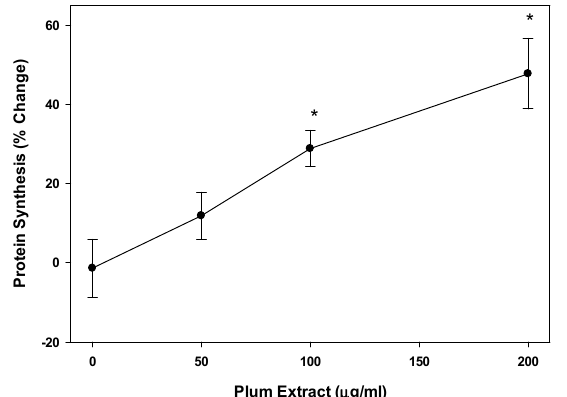
Figure 3. The effect of plum extract on myotubule protein synthesis. Protein synthesis was measure by the incorporation of labeled phenylalanine into total myotubule proteins in response to various levels of plum extract. Data were computed as cpm / mg of proteins followed by calculation of % change over control. The data were expressed as mean ± SD for at least three experiments. All comparisons were made to control (untreated cells) using one-way ANOVA; significant differences are reported at * p <